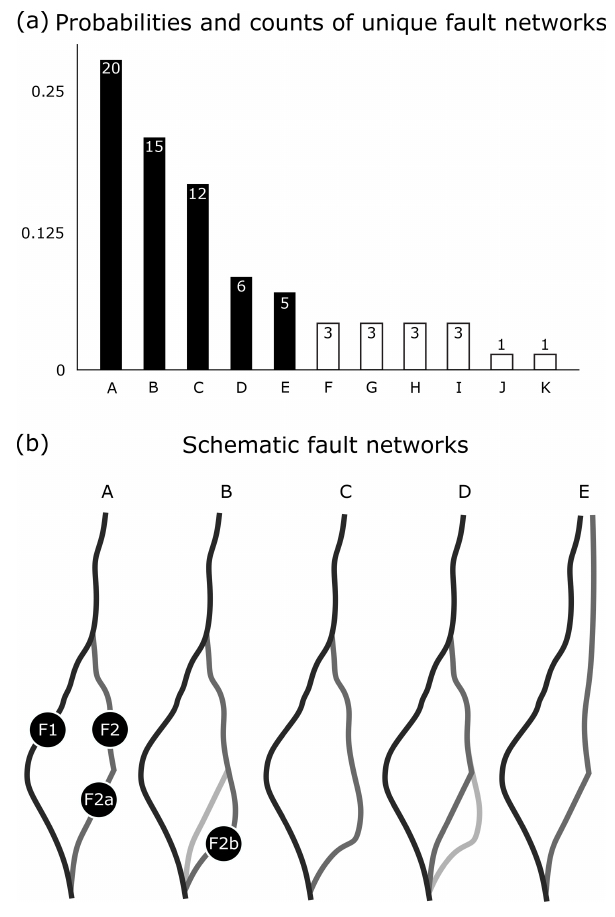
Figure 5. Probabilities of unique fault network topologies (a) with corresponding schematic fault networks (b) of the five most likely